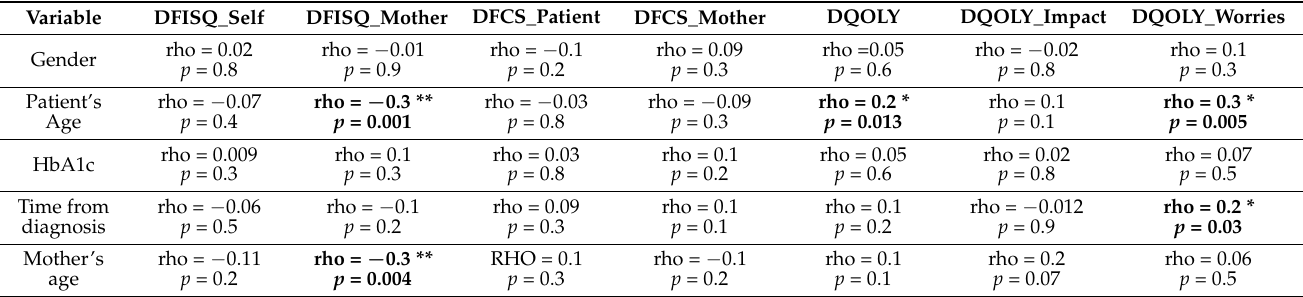
Table 4. Spearman’s correlations between socio-demographic and diabetes factors with quality of life, fear of self-injecting and family conflict in patients and their